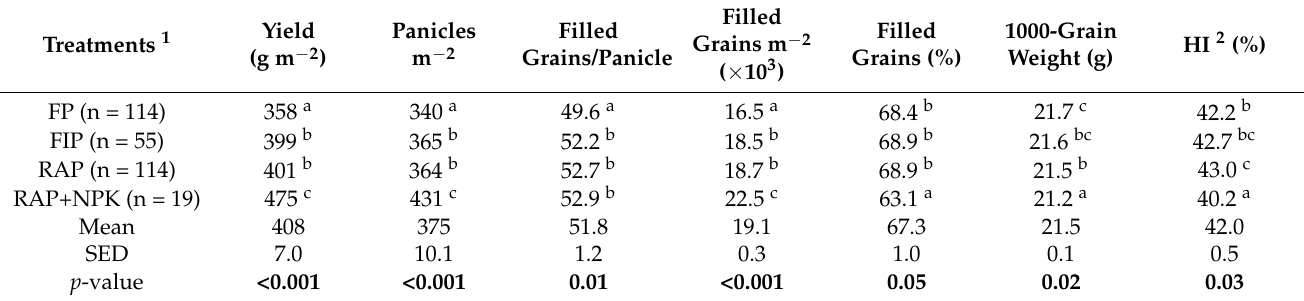
Table 2. Grain yield and yield components under different management levels on farmers’ fields, Doho 2019.